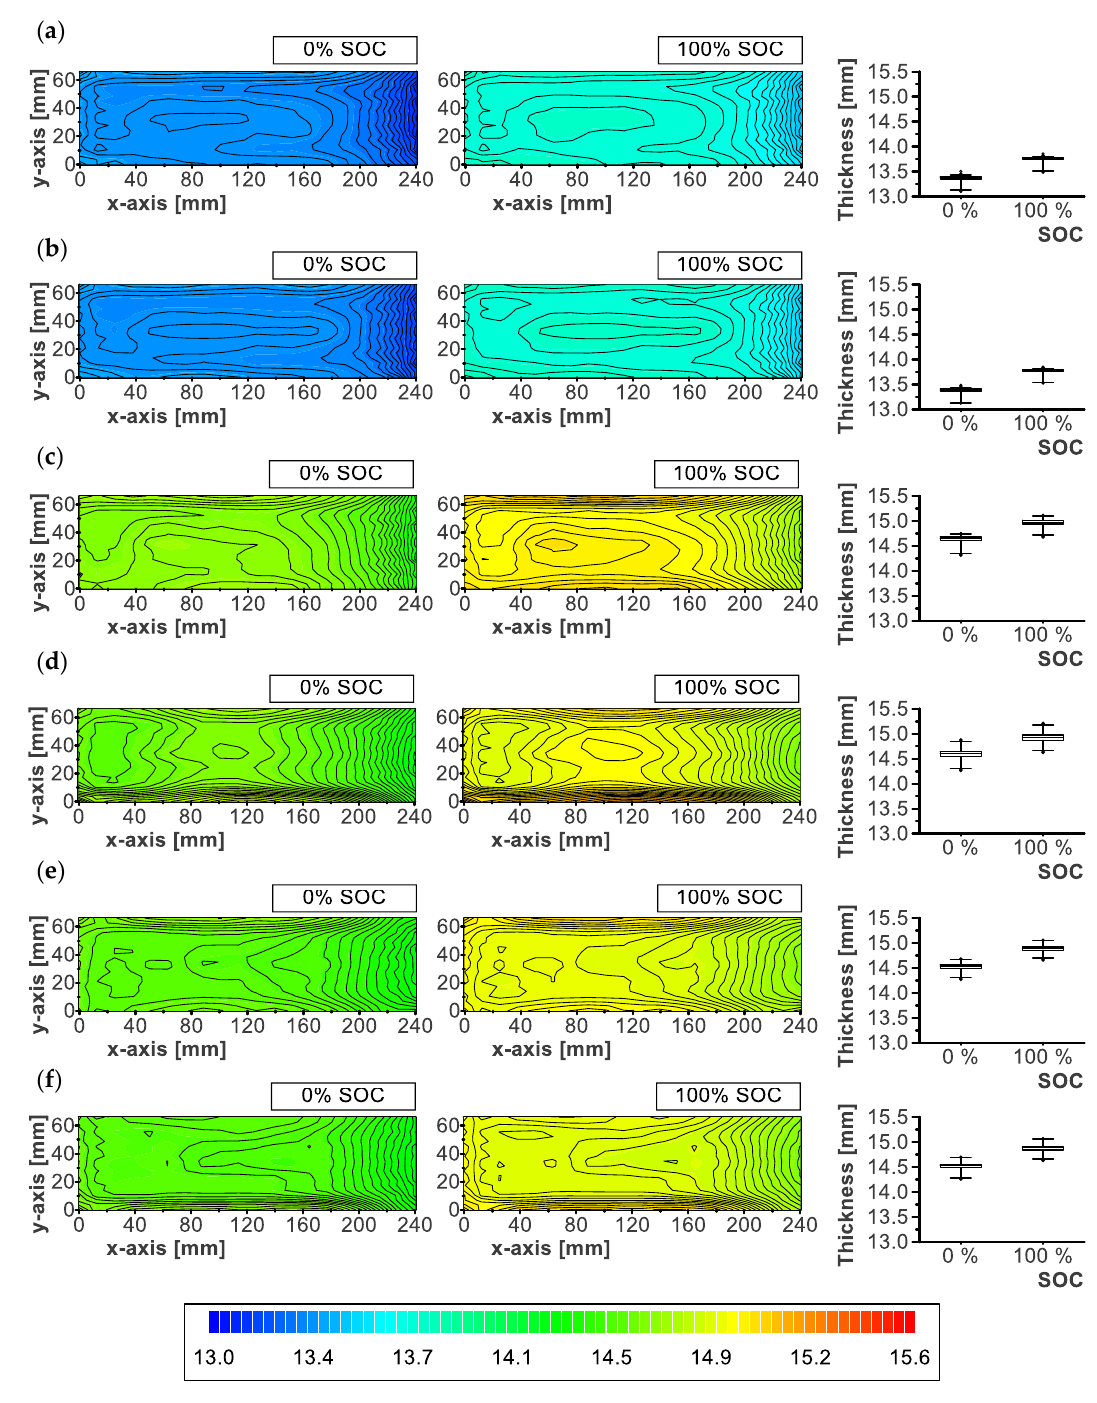
Figure 8. Local thickness of pouch cells in mm for 0% and 100% SOC averaged over two repetitions. Boxplots of local thickness. ( a ) F1. ( b ) F2. ( c ) A1. ( d ) A2. ( e ) B1. ( f )